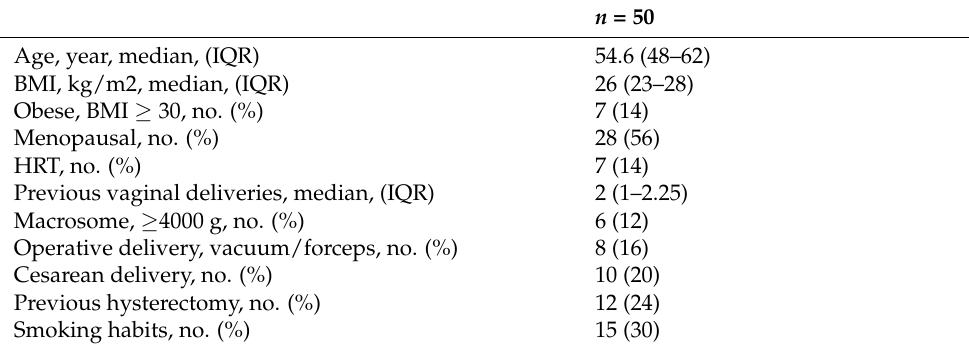
Table 1. Patient characteristics at baseline.